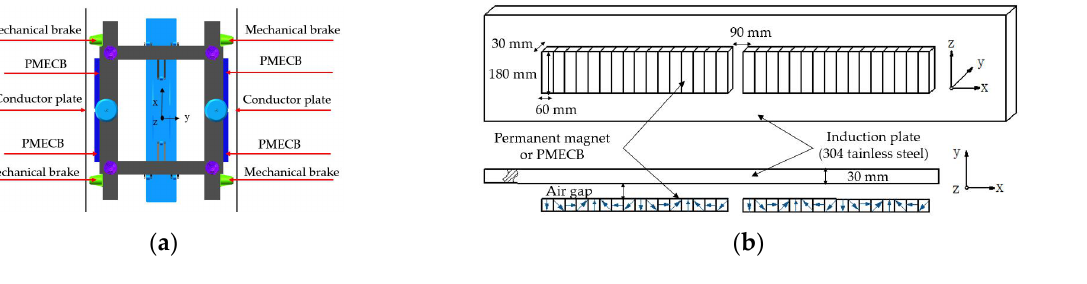
Figure 2. Schematic of ( a ) the arrangement of four PMECBs and ( b ) the equivalent two-dimensional unilateral simulation model of two PMECBs.